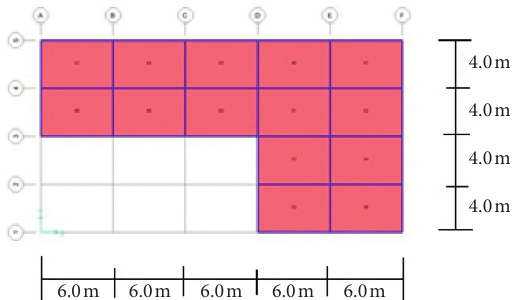
Figure 1: Plan view of the model.